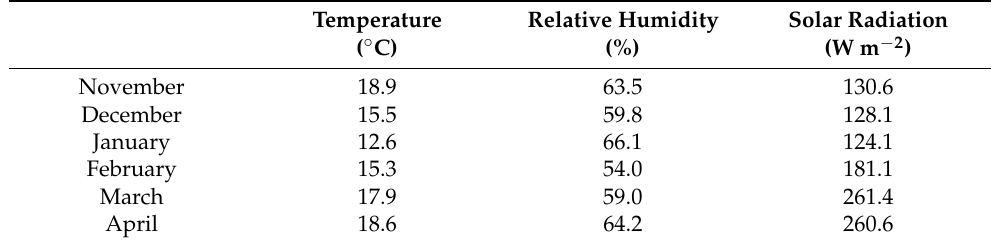
Table 1. Monthly daytime average values for temperature, relative humidity, and solar radiation during the experiment (20 November 2018–17 April 2019) inside the